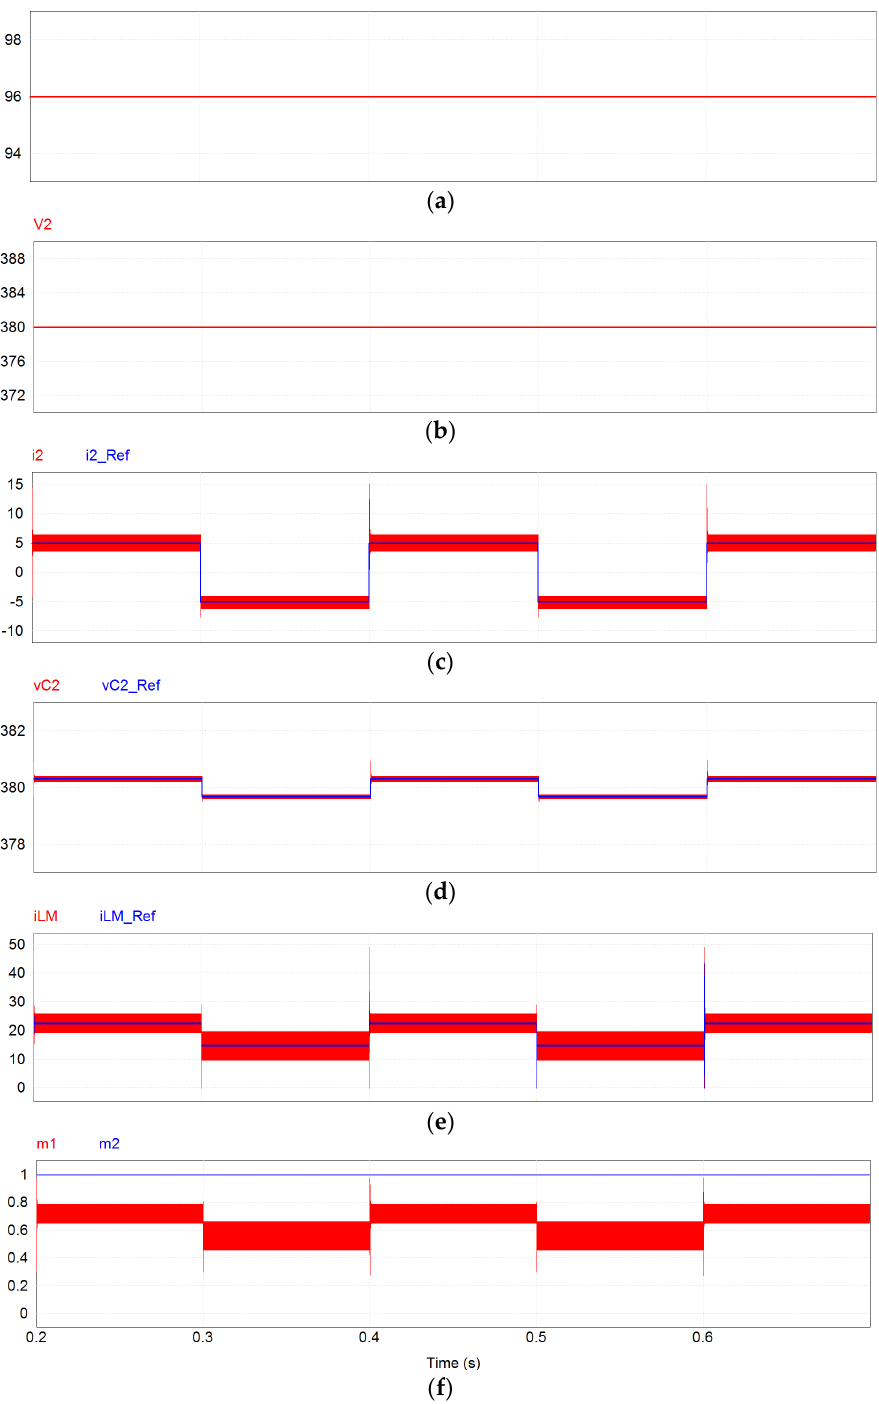
Figure 13. Waveforms for the dual-state buck – boost control with conventional cascaded control loops. ( a ) Voltage at Bus 1 (in V), ( b ) voltage at Bus 2 (in V), ( c ) reference and output current (in A), ( d ) reference and output capacitor voltage (in V), ( e ) reference and inductor current (in A), ( f ) PWM modulation